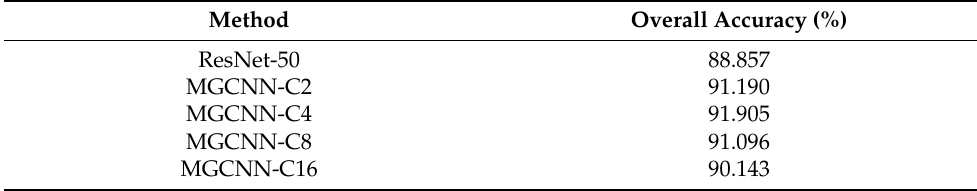
Figure 11. CM of ResNet-50 obtained with the UC-Merced dataset. Table 6. Overall accuracy (OA) achieved by the MGCNN with UC-Merced